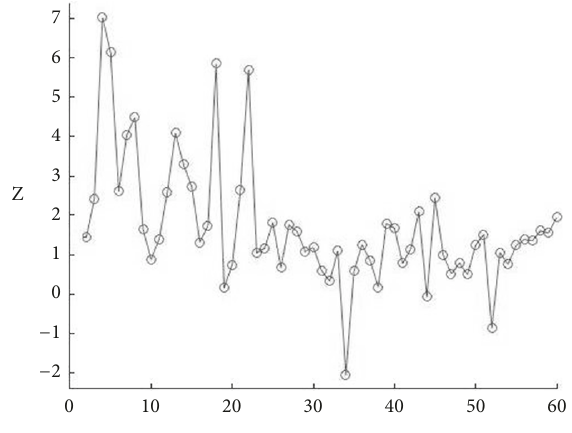
Figure 6: Graph Z ( n ) for William Blake’s poem “The